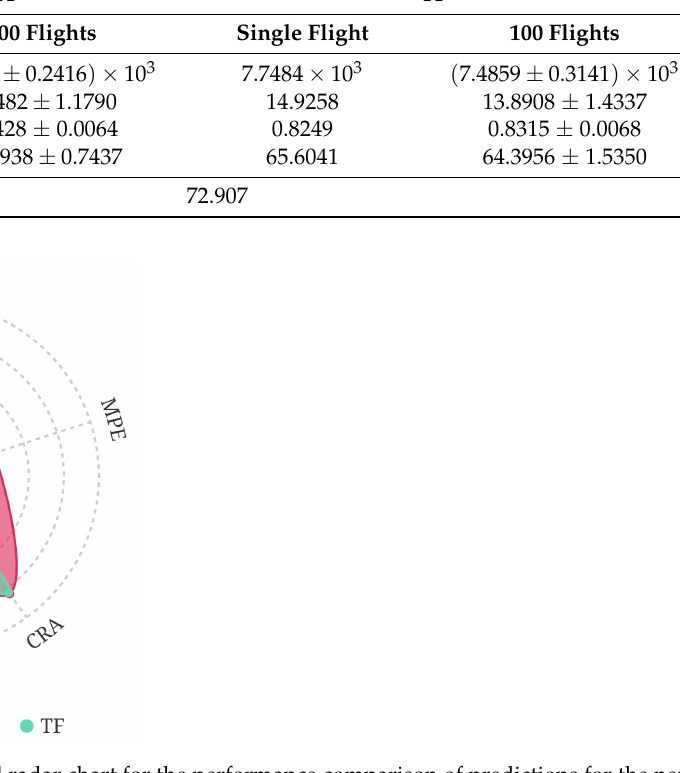
Figure 12. The 5-dimensional radar chart for the performance comparison of predictions for the next 128 s. The performance depicted in the radar chart ranges from 0 to 1 (from low to high).